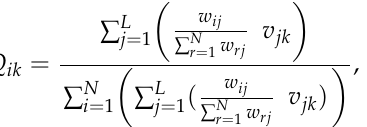
90110 Figure 6. Comparison of all experimental results and ANN model predicted values. 5070